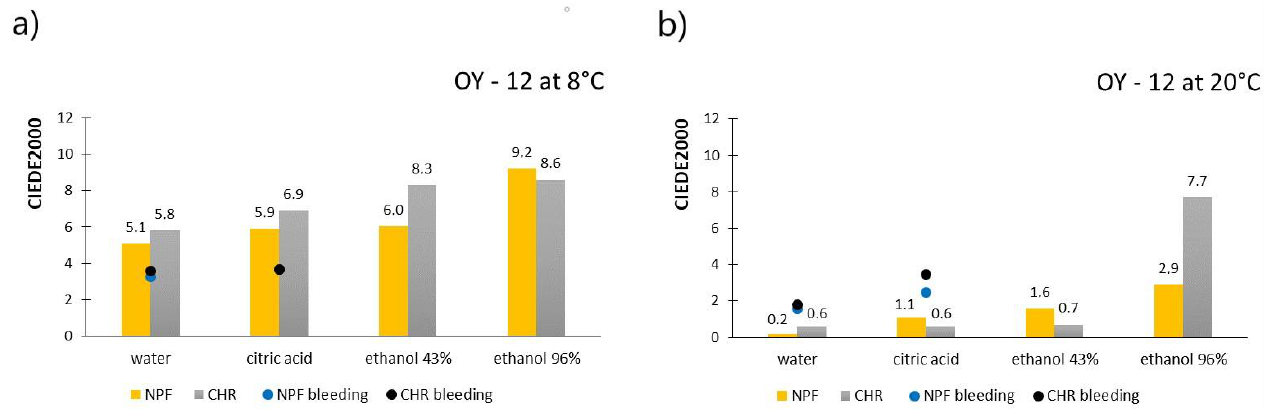
Figure 6. CIEDE2000 measured on OY-12 prints below ink’s T A ( a ) and CIEDE2000 measured on OY-12 prints above ink’s T A ( b ).